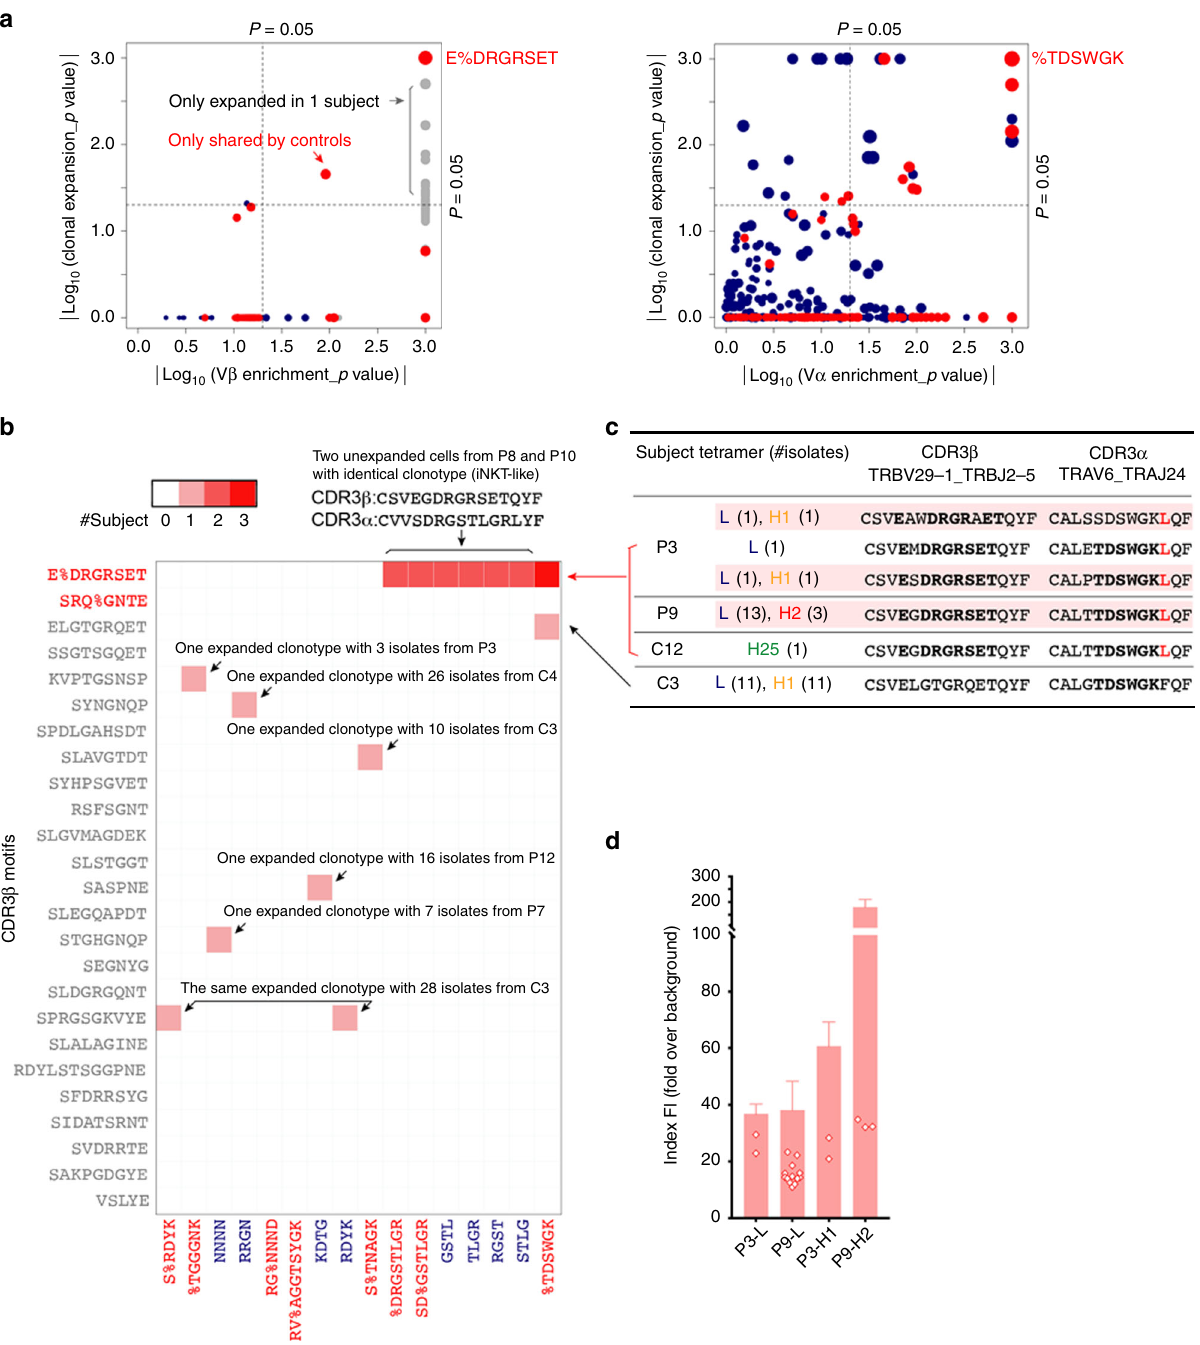
Fig. 5 Public features of the eTRAJ24 clonotypes. a Analysis of CDR3 motifs shared by groups of TCR β (left) or TCR α (right) by GLIPH algorithm 24 . Each dot represents one motif: global (red), local (blue), and single (gray) (see Supplementary Data 4 for de fi nitions). 25 CDR3 β motifs and 16 CDR3 α motifs reach signi fi cance ( P < 0.05, the upper right quadrant) when analyzed for enrichment of V genes and expanded clones compared to a reference dataset as described 24 . The α / β motifs used in eTRAJ24 clonotypes (shown in red to the right of each plot) have the highest overall signi fi cance. The radius of dots re fl ects the fi nal score (see details in Supplementary Data 4). b Number of subjects with clonotypes using paired α / β motifs from the 25 β and 16 α motifs. Motifs are color-coded as in a . #clonotype with #isolates from the indicated donor(s) is also shown on the heatmap or summarized in c . c Summary of tetramer-identi fi ed clones expressing TRBV29-1_TRBJ2-5/TRAV6_TRAJ24 genes. The L residue of the G (SNP) allele is indicated in red. The three eTRAJ24L clonotypes are shaded. The CDR3 sequences using E%DRGRSET and/or %TDSWGK motifs are bolded. d Tetramer binding rank of individual eTRAJ24L + cells. Bar graphs represent the mean ± SEM FI of all sorted CD4 + /tetramer + single cells from the indicated subject-tetramer category. Open symbols are for only eTRAJ24L + cells within the same subject-tetramer category, as in the corresponding bar graph. All values are normalized with background MFI of the entire CD4 + population in the tetramer detection